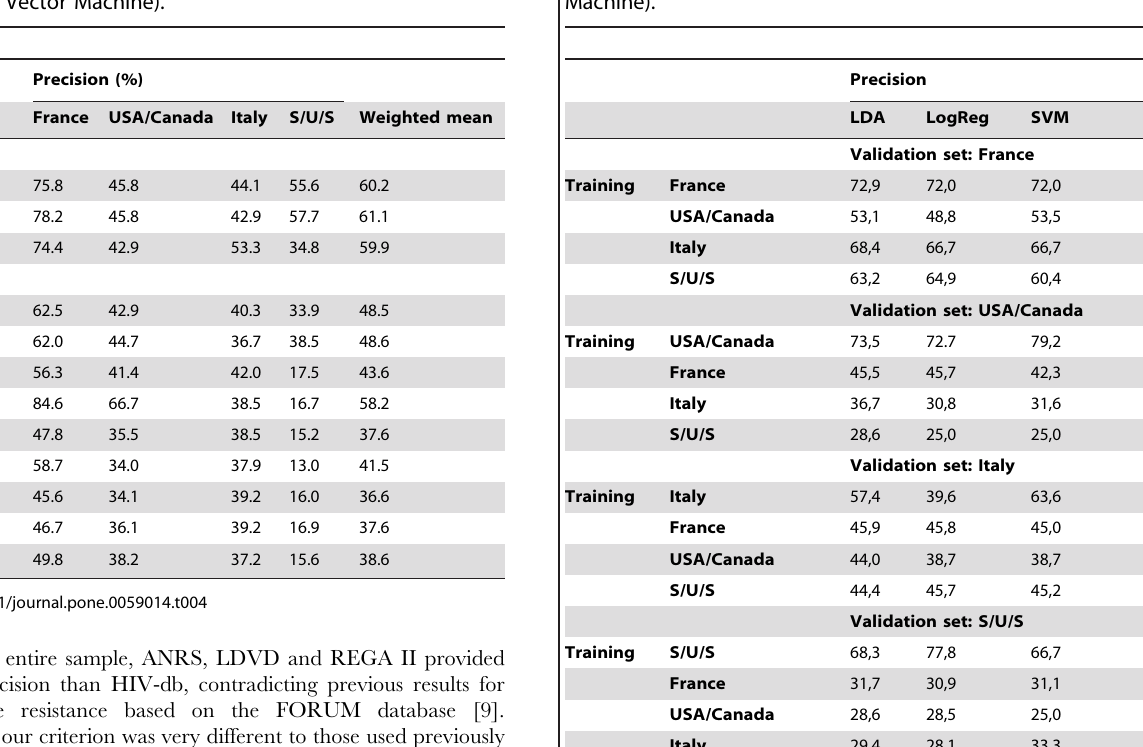
Table 4. Precision for global scores, obtained from the three statistical methods, and existing IS for each country-based data sets (S/U/S: Spain/UK/Switzerland; LDA: Linear Discriminant Analysis; LogReg: Logistic Regression, SVM: Support Vector Machine).